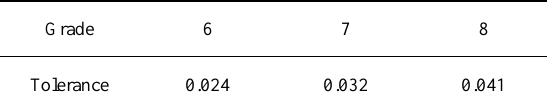
Table 10. Angle tolerance of the pitch circle (degree) Grade 6